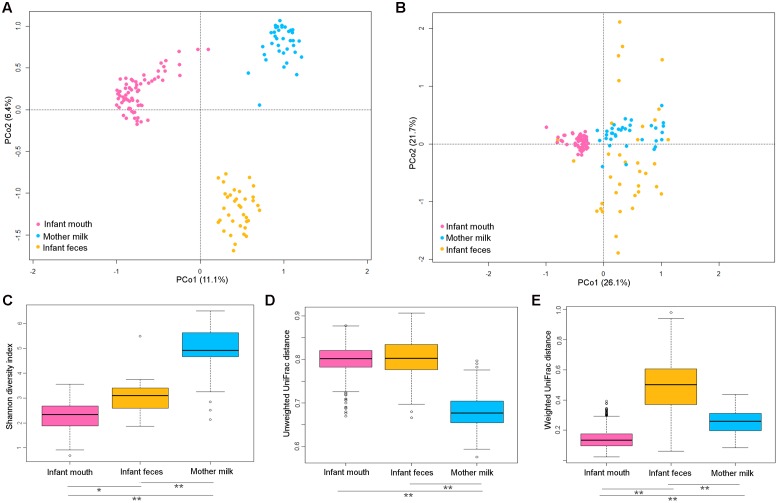
Diversity in the bacterial ecosystem of the mother’s milk, and infant’s feces and mouth. PCoA based on unweighted (A) and weighted (B) UniFrac distances of the microbiota of mother’s milk (light blue), infant feces (yellow), and infants mouth (pink). Samples are identified by filled circles. In both PCoA first and second principal components (PCo1 and PCo2) are plotted. The percentage of variance in the dataset explained by each axis is reported. Box and whiskers distribution of the Shannon α-diversity index (C), intra-group unweighted UniFrac distances (D), and intra-group weighted UniFrac distances (E), calculated for milk (light blue), fecal (yellow) and oral (pink) samples. Significant differences between datasets are indicated, as calculated using Tukey post hoc test after Kruskal–Wallis test for multiple comparisons (∗P ≤ 0.001, ∗∗P ≤ 0.0001).